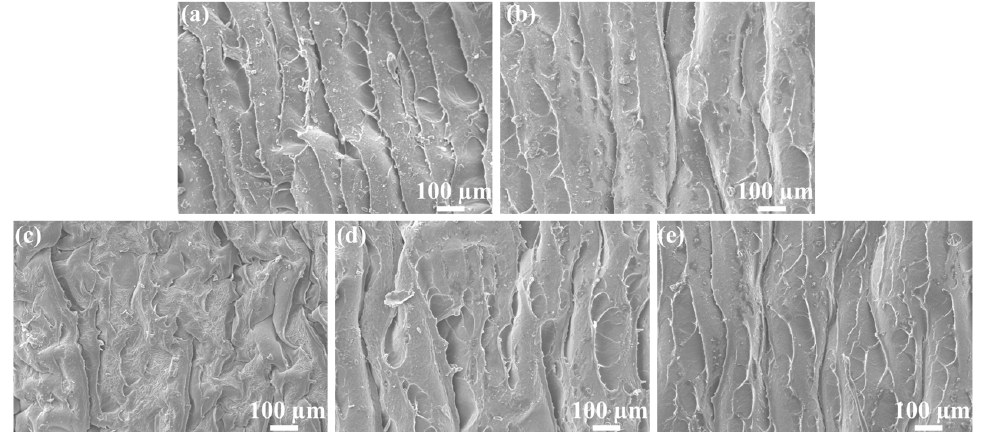
Figure 9. The internal SEM images of OIM@PAM after releasing for 168 h in different pH solutions. ( a ) pH 3, ( b ) pH 5, ( c ) pH 7, ( d ) pH 9 and ( e ) pH 11.